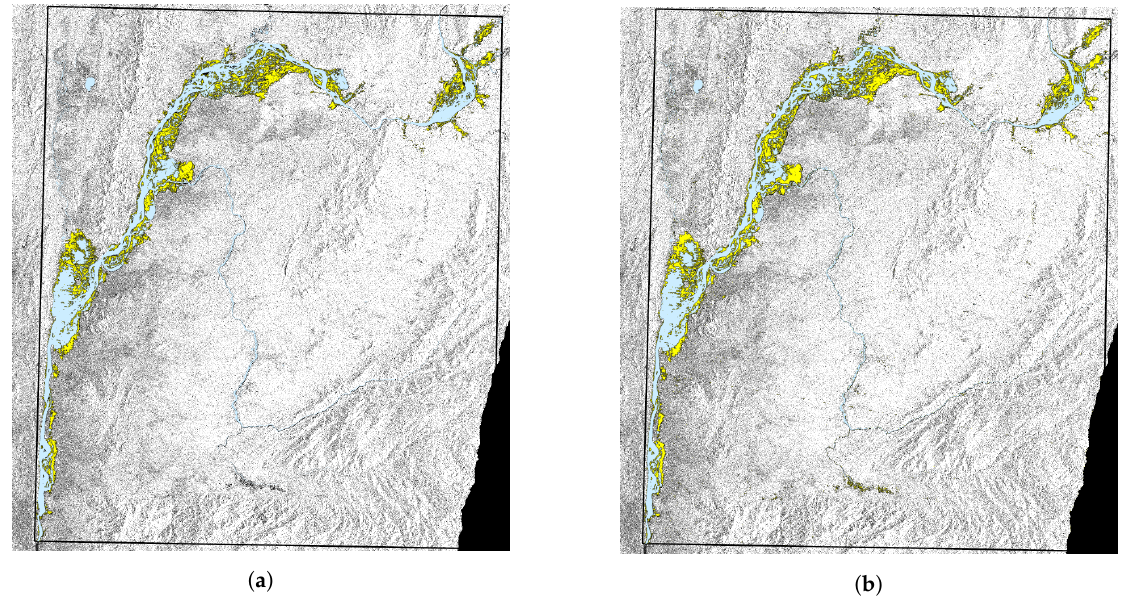
Figure 11. Analysis of Sagaing Region on the 18th July 2019 with permanent water and labels. The images show the area of interest in black outline and the permanent water in light-blue. ( a ) shows the classically generated label in yellow. ( b ) shows the machine learning prediction in yellow. Neither the label nor the prediction include any permanent